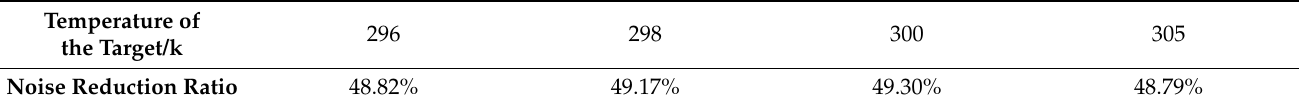
Table 3. Calibration effect at different target